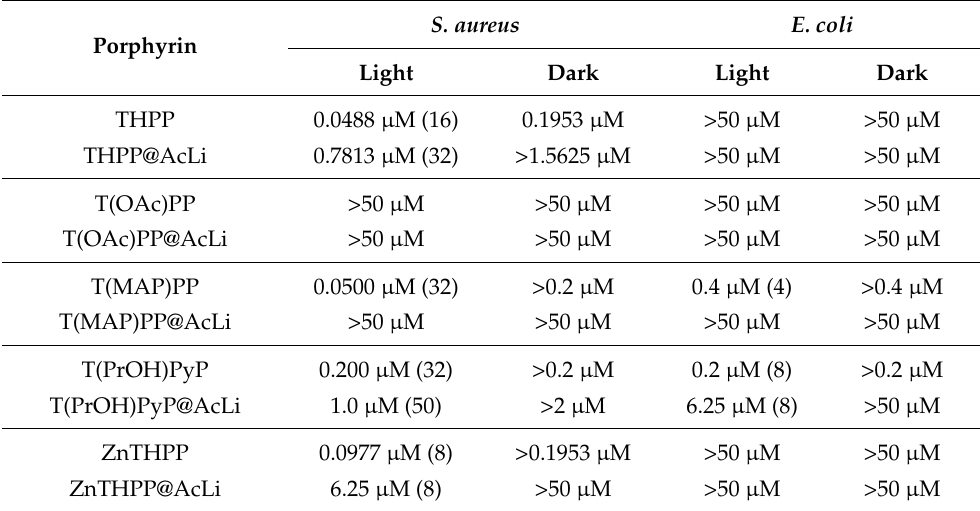
Table 6. Minimal bactericidal concentrations found for S. aureus and E. coli , when treated with the free or encapsulated porphyrins. Irradiated bacteria were incubated with the treatment for 30 min, before irradiation under blue-LED light (15 J/cm 2 ). In parenthesis is indicated the rate MIC/MBC for the concentrations where MBC could be precisely